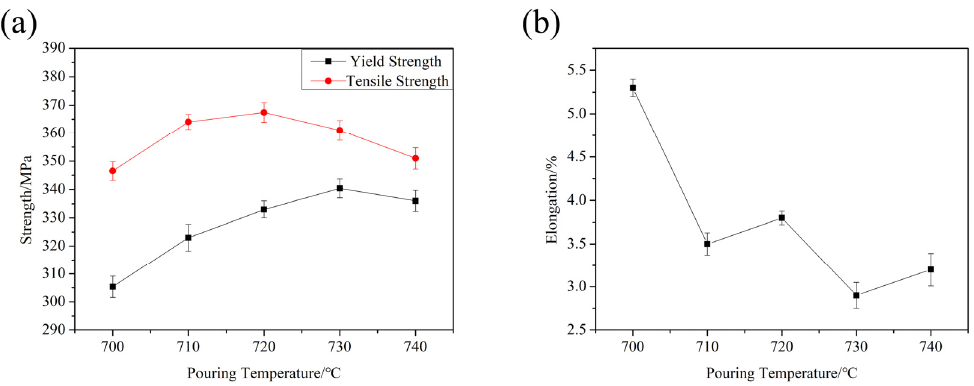
Figure 8. Strength and elongation of the samples at different casting temperatures: ( a ) strength; ( b ) elongation.